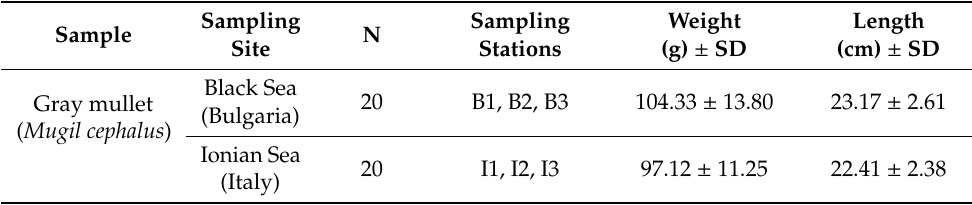
Table 1. Biometrics data (mean ± SD) of the grey mullet sampled from the coastal waters of the Black Sea (Bulgaria) and the Ionian Sea